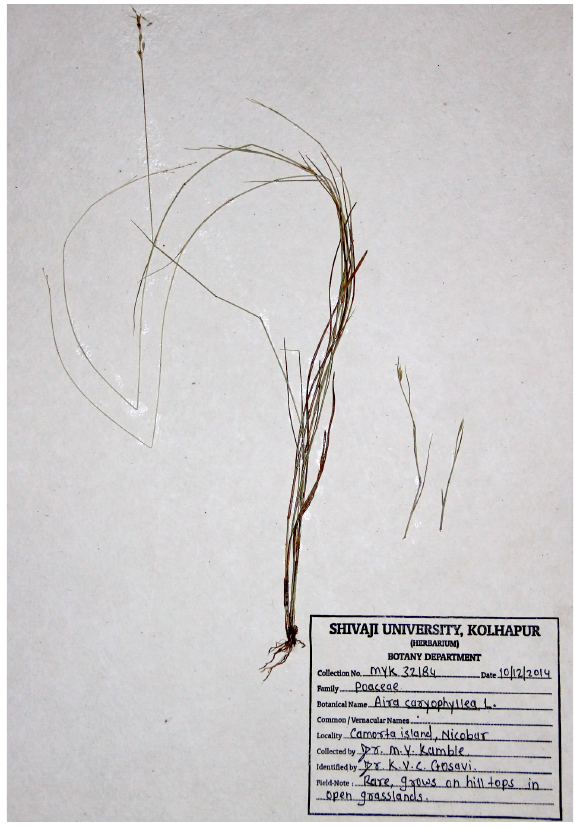
Image 2. Herbarium of Aira caryophyllea